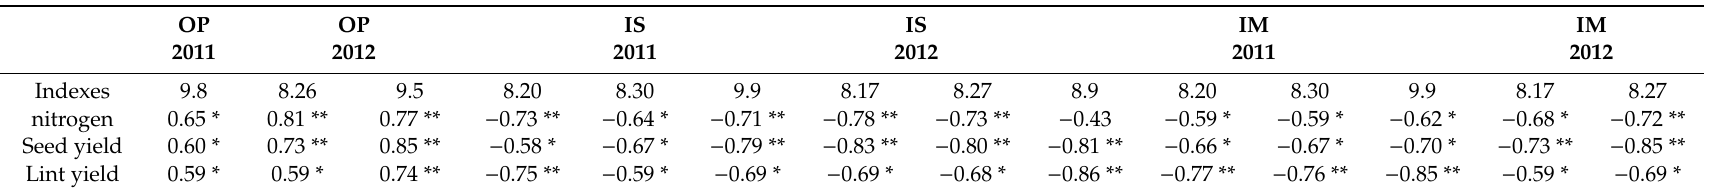
Table 5. The correlation coe ffi cients between nitrogen treatment, seed yield, lint yield, and physiological indexes in seeds of upper fruiting branches. ISP ISS OSS ISP ISP ISM OSM ISM OSM